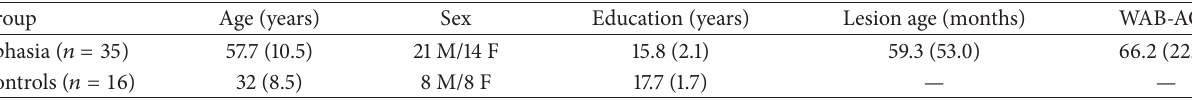
1 WAB-AQ: Western Aphasia Battery-Aphasia